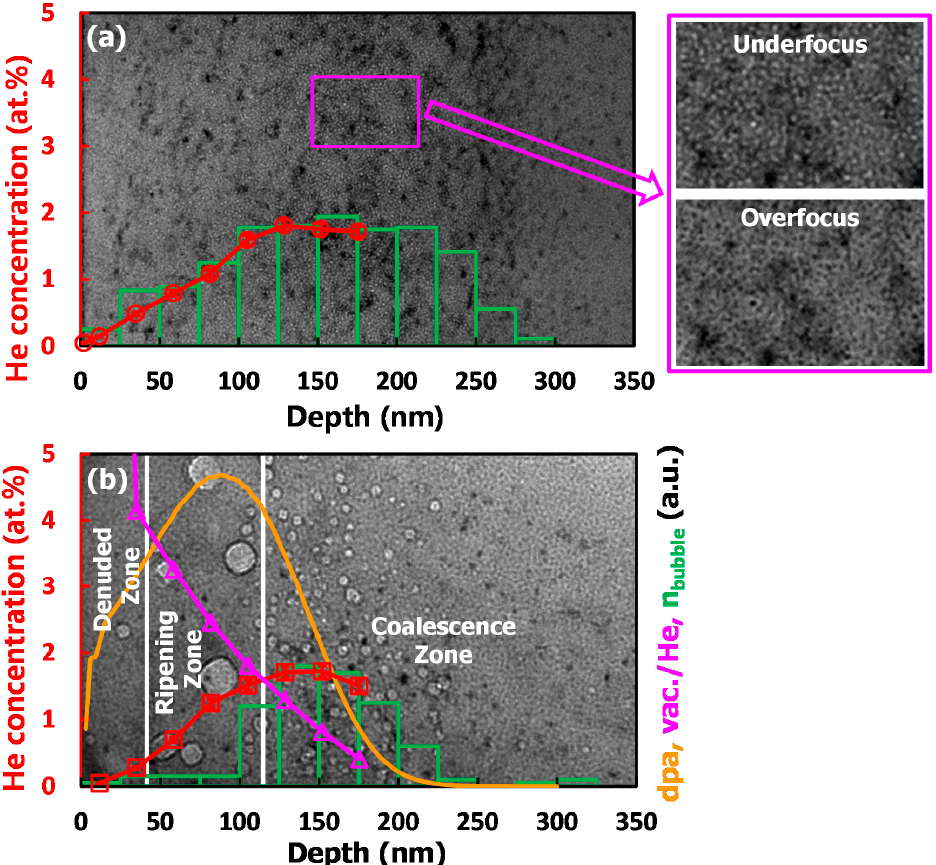
Figure 2. Transmission electron microscopy (TEM) images of the helium-irradiated Hastelloy N alloy in the case of ( a ) annealing at 600 °C (1 h) and ( b ) annealing at 600 °C (1 h) + 850 °C (5 h). The profiles related to the evolution of helium concentration, normalized number of helium bubbles, damage depth profile (dpa), and ratio of vacancy to helium (vac./He) are also given in this figure.